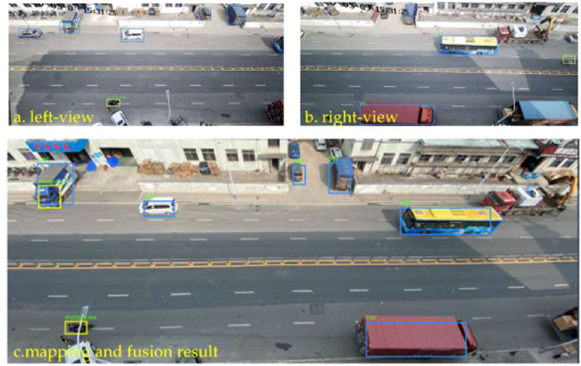
Figure 3. Object detection from different angles based on image fusion. Table 2. Summary and analysis of image fusion research methods.